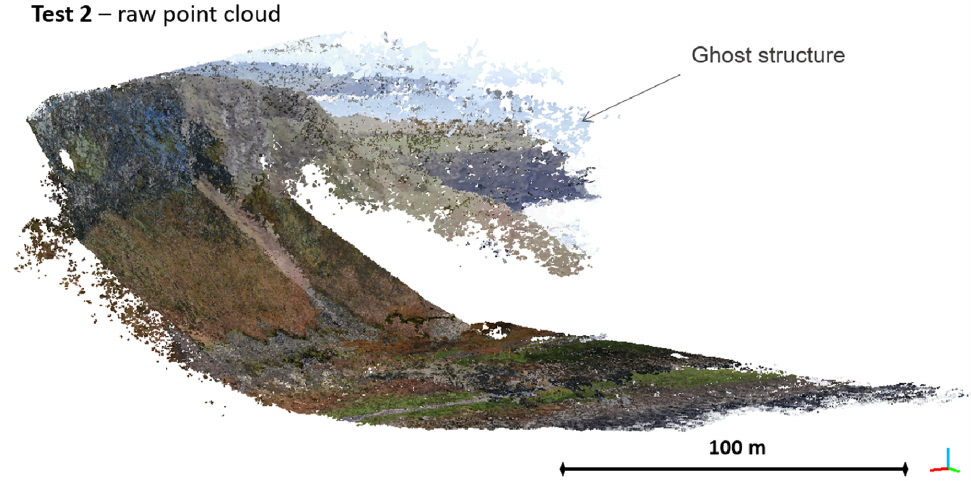
Figure 6. Example of «ghosting effect» on the raw dense point cloud generated by Agisoft Metashape for Test 2.